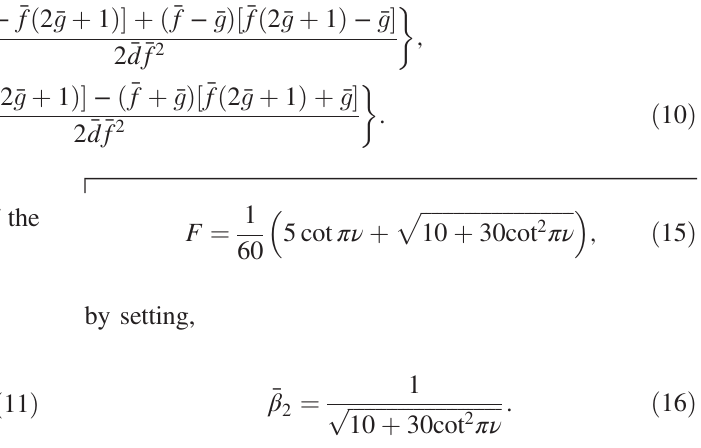
1 ffiffiffiffiffiffiffiffiffiffiffiffiffiffiffiffiffiffiffiffiffiffiffiffiffiffiffiffi